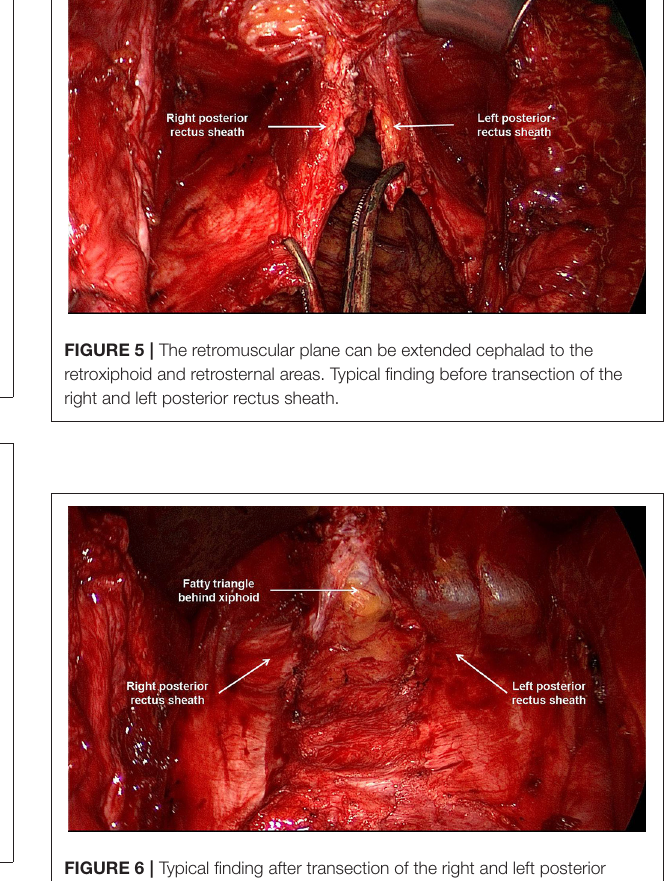
FIGURE 6 | Typical finding after transection of the right and left posterior rectus sheaths and opening of the space between fatty triangle and